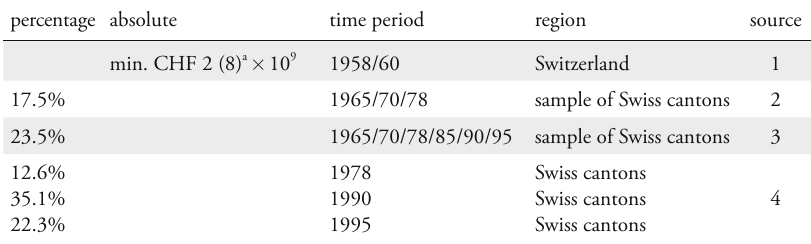
Table 7: Summary of Estimates of Non-Declared Income in Switzerland Based on Comparisons of National Accounts and Income Tax